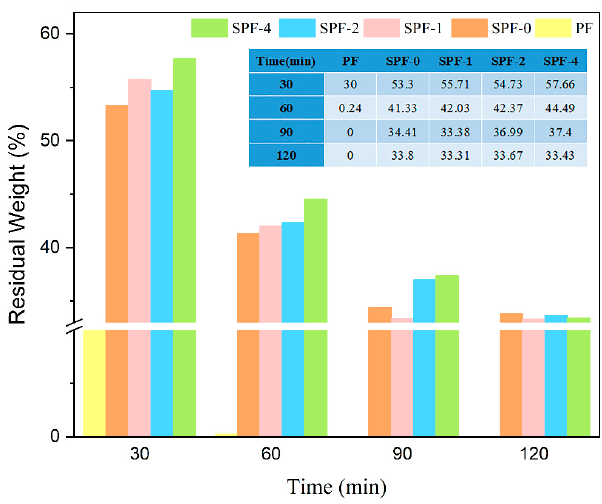
Figure 14. The weight retention of the cured SPFs after oxidation at 1000 °C for a different time in a muffle furnace.